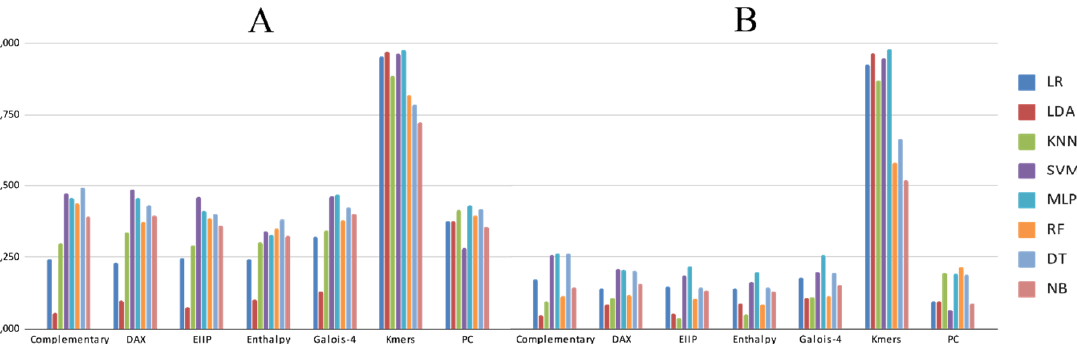
Figure 2. Performance of machine learning (ML) algorithms and Repbase pre-processed data by principal component analysis (PCA) and scaling processes using as main metric: ( A ) accuracy and ( B ) F1-score.